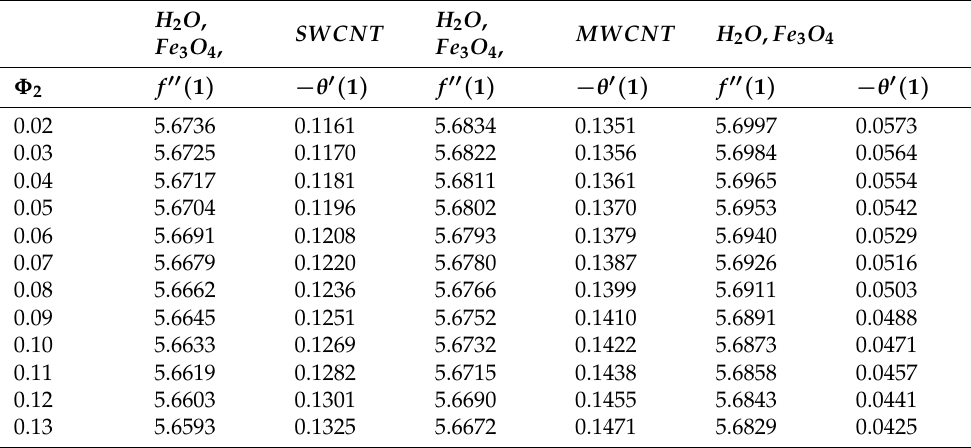
Table 6. Numerical results by parametric continuation method for hybrid nanofluid with various physical parameters.